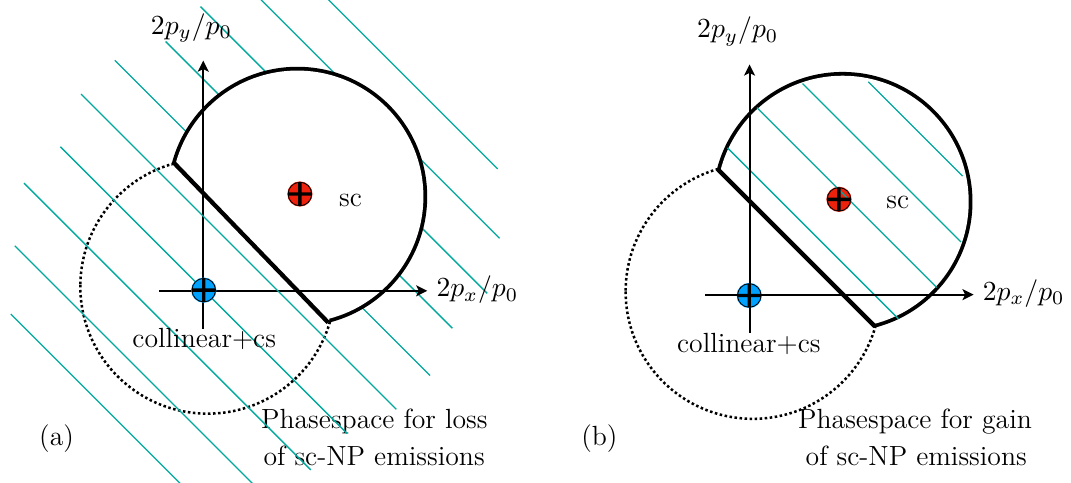
Figure 10 . (a) The case where the sc subjet loses an NP emission (b) The case when the sc subjet gains an NP